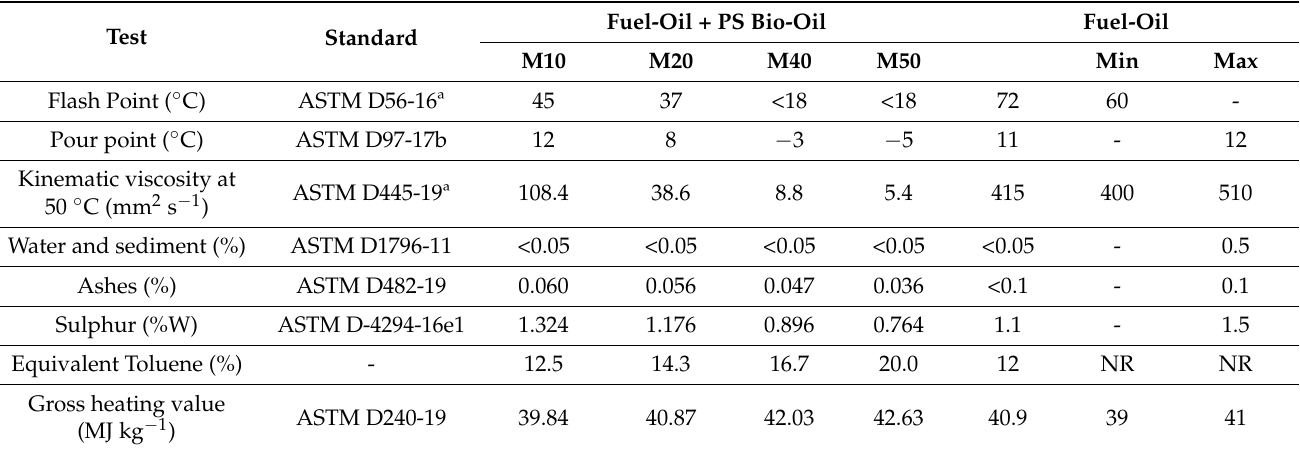
Table 4. Characteristics of the new bio-oil/Fuel-oil